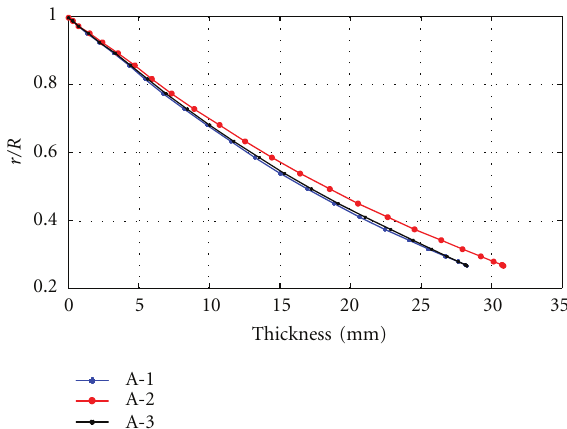
Figure 15: Thickness distribution, fore